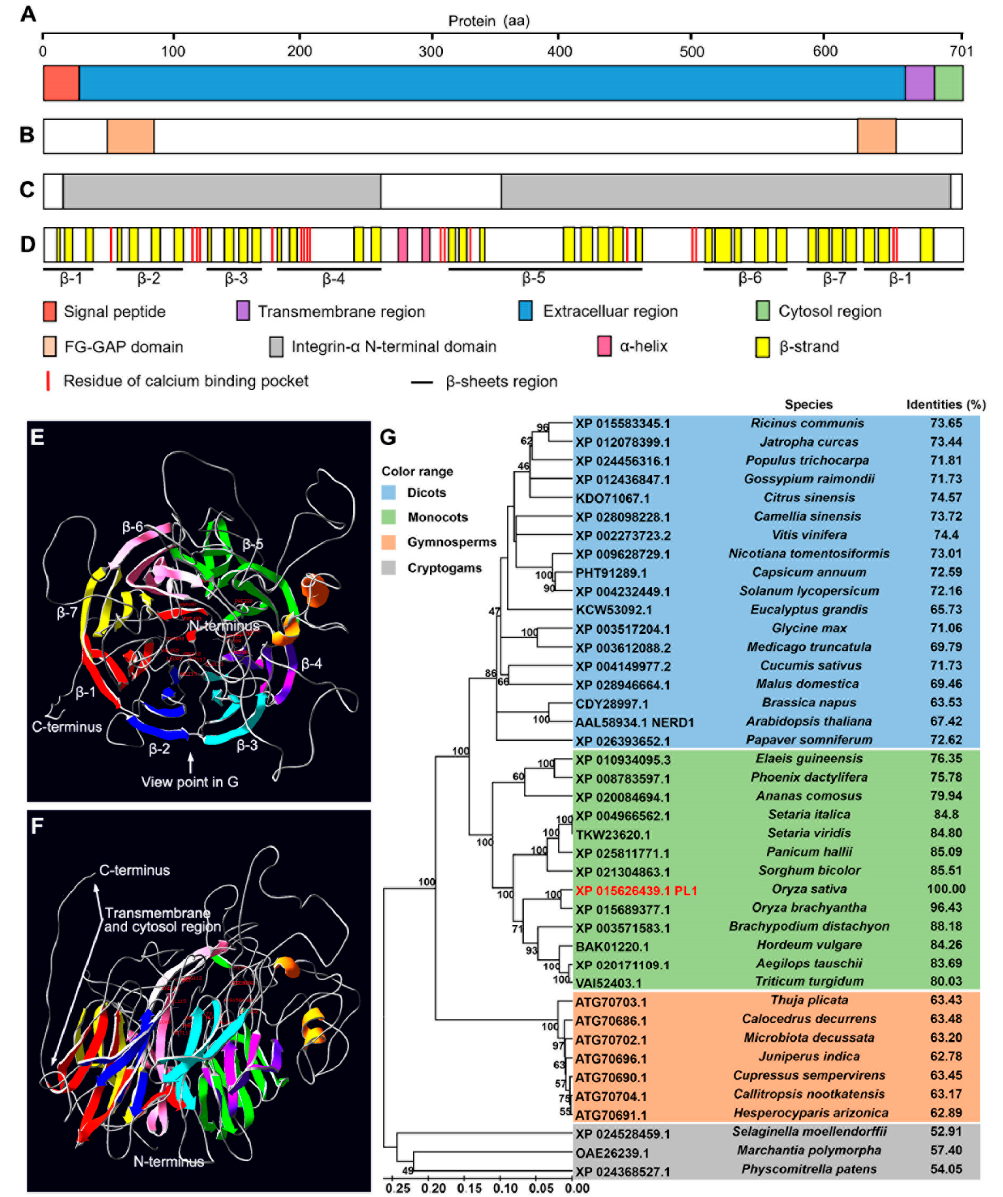
Figure 4. Protein sequence analysis of PL1. ( A ) Domains of PL1 determined by TMHMM 2.0. aa, amino acids. ( B ) FG-GAP repeat domains of PL1 determined by SMART. ( C ) Integrin α N-terminal domains of PL1 determined by InterProScan. ( D ) Seven-bladed β -propeller and residues of Ca2 + -binding pocket predicted by RaptorX. ( E ) Ribbon diagrams of the model for PL1 predicted by RaptorX. ( F ) Side view of the model in E. Each β -sheets (from β -1 to β -7) is shown in a di ff erent color. The N-terminus, C-terminus and the transmembrane and cytosol region are indicated. ( G ) Phylogenetic tree of PL1 and its related homologs. The proteins are named according to their GenBank IDs (Table S4). The numbers at the nodes indicate the bootstrap